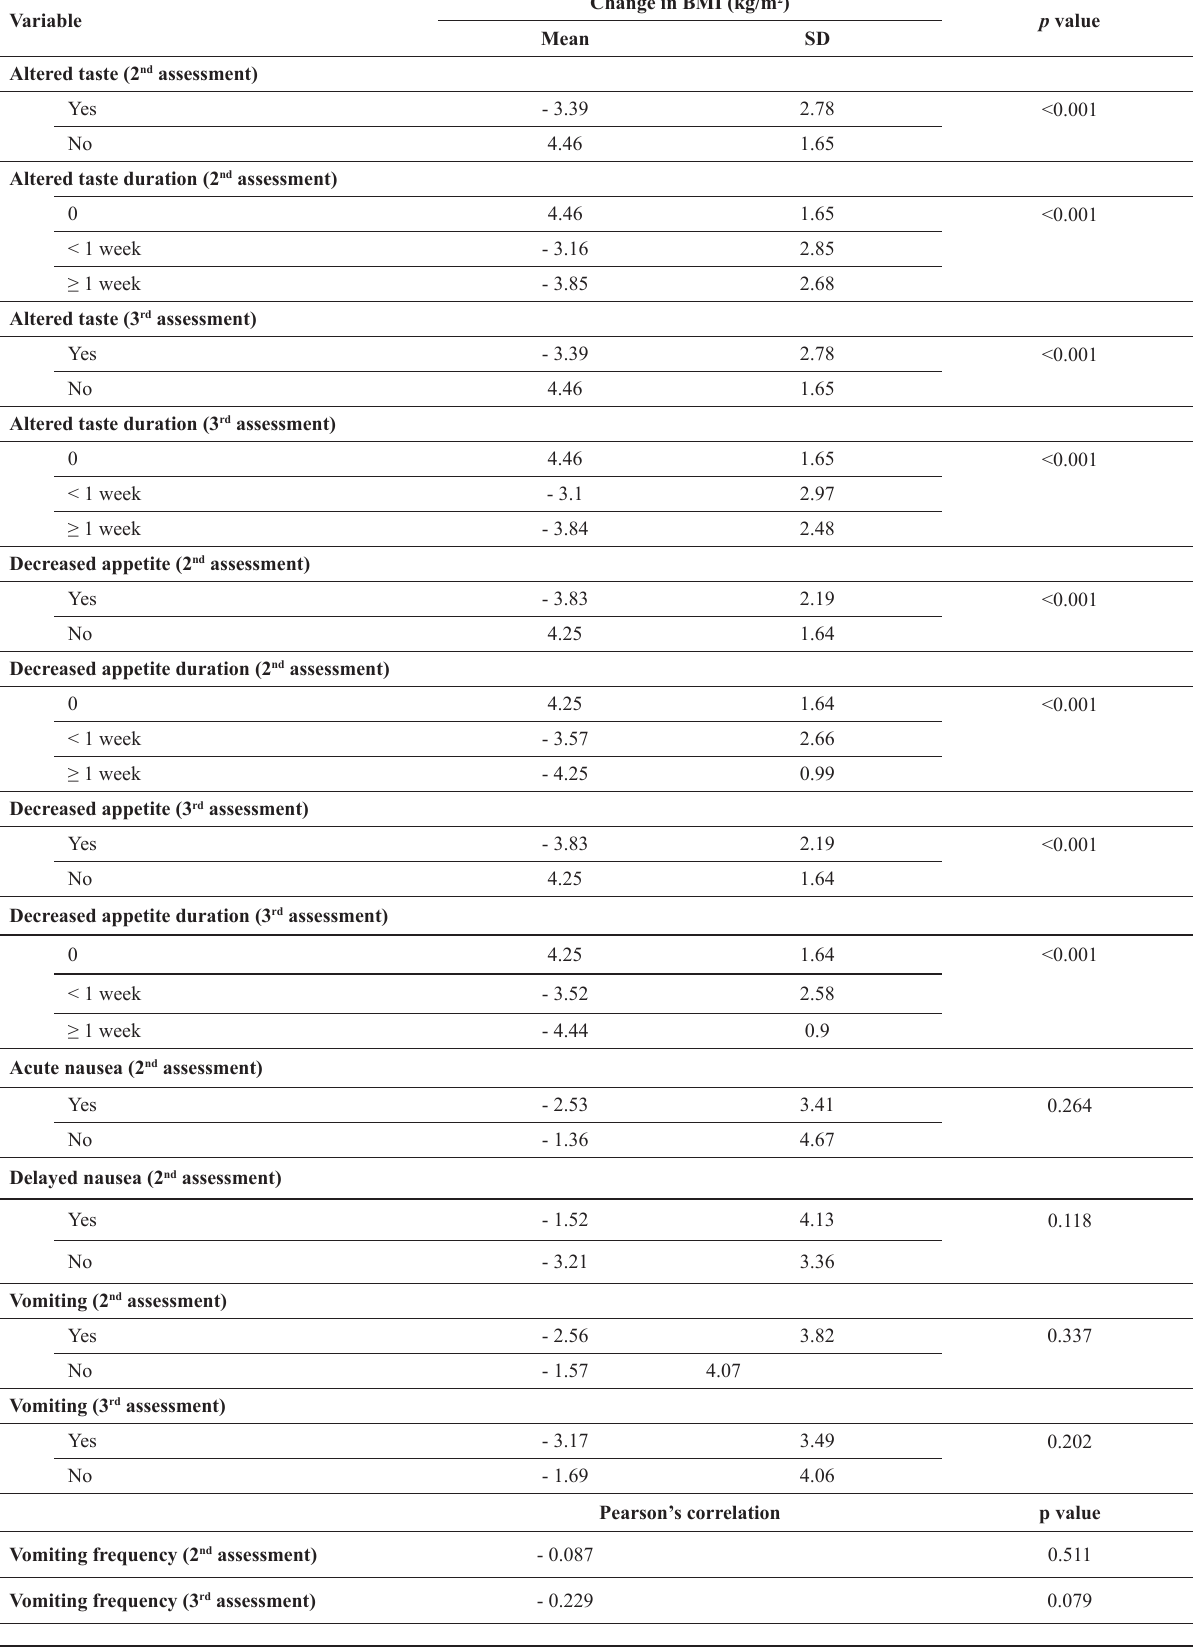
Table 6: Correlation between selected variables and the change in body mass index (BMI).